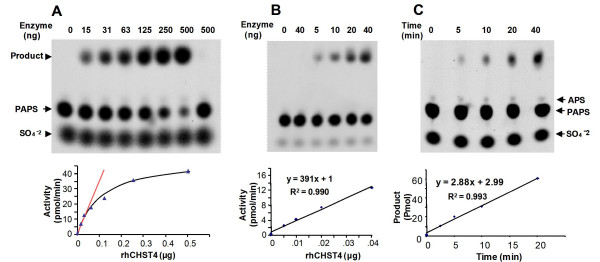
Assay development for rhCHST4. The enzyme was assayed with the acceptor substrate of a disaccharide GlcNAcMan. A) Activity-enzyme plot and the linear response region. The reactions were performed with fixed substrate inputs (2,500 pmol GlcNAcMan and 1,000 pmol of PAPS) but varied enzyme input from 0 to 500 ng. The calculated activity was then plotted against the enzyme inputs. The linear response region was located from 0 to 40 ng of enzyme input. Last lane contained no acceptor substrate. B) The experiment was repeated in the linear region. A linear least-square line was fitted to the activity-enzyme plot and the slope of the line was the specific activity for rhCHST4. The second lane contained no acceptor substrate. C) A product-time course of rhCHST4. All reactions contained 7.5 ng enzymes but reaction time varied from 0 to 20 minutes. The relative mobilities of the product and PAPS were slightly different due to variations on the electrophoresis buffer preparation. The faint spots right above the PAPS were likely due to APS, a PAPS degradation product, which was observed especially with aged PAPS preparation.